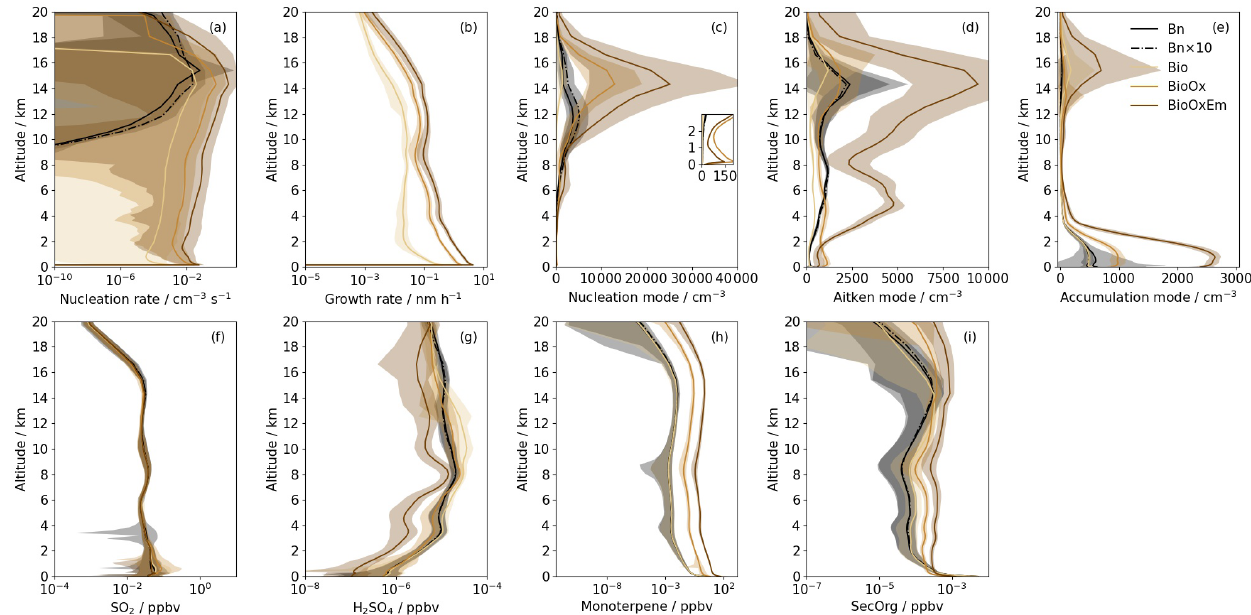
Figure 5. Regional domain- and time-averaged vertical profiles of ambient (a) nucleation rate (up to 3nm in diameter), (b) growth rate in the biogenic nucleation mechanism (from 1.7 to 3nm), (c) nucleation mode aerosol number concentrations (with the inset figure showing the number at the lowest 3km), (d) Aitken mode aerosol number concentrations, (e) accumulation mode aerosol number concentrations, (f) SO 2 volume mixing ratios, (g) H 2 SO 4 volume mixing ratios, (h ) monoterpene volume mixing ratios, and (i) secondary organic (SecOrg; the oxidation product of monoterpene) volume mixing ratios. The results are from the simulations with binary nucleation (Bn; black solid), binary nucleation with 10 times nucleation rate (Bn × 10; black dotted dashed), pure biogenic nucleation (Bio; light brown), biogenic nucleation with reduced ( ÷ 10) oxidation rate (BioOx; brown), and biogenic nucleation with reduced oxidation rate and enhanced ( × 10) monoterpene emission (BioOxEm; dark brown). The shading represents 1 standard deviation either side of the mean at each height.